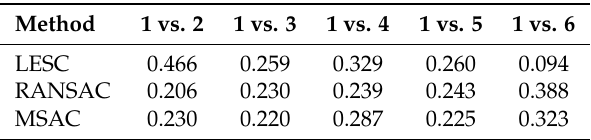
Table 8. The computation time (in seconds) of LESC, RANSAC and MSAC respectively on the Leuven sequence using the 1st image versus the rest of images.